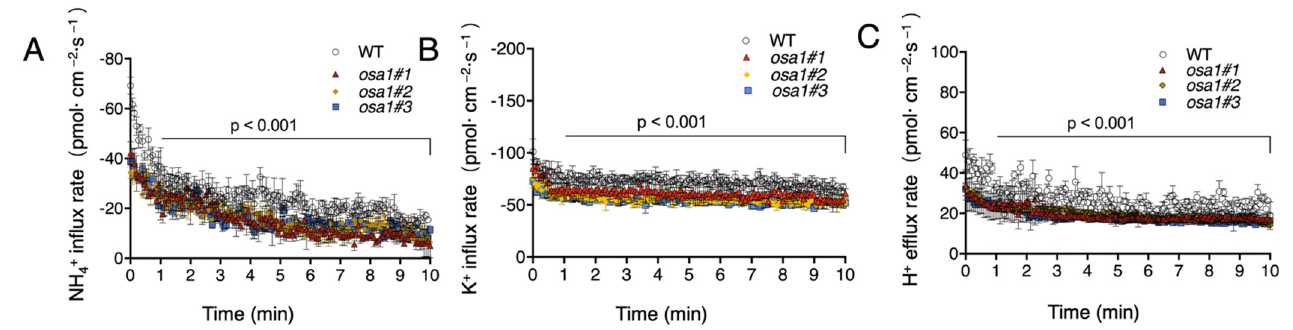
Figure 7. Quantification of NH 4+ influx, K + influx, and H + efflux rates of WT and osa1 mutant roots. The 5-day-old seedlings of WT and osa1 mutants were treated with a hydroponic solution lacking NH 4+ for 24 h. Intact roots were equilibrated in the measuring solution for 10 min. The NH 4+ influx rate ( A ), K + influx rate ( B ), and H + efflux rate ( C ) were tested. Values are means ± SD ( n = 3). Significant difference was evaluated using the two-tailed Student’s t- test.